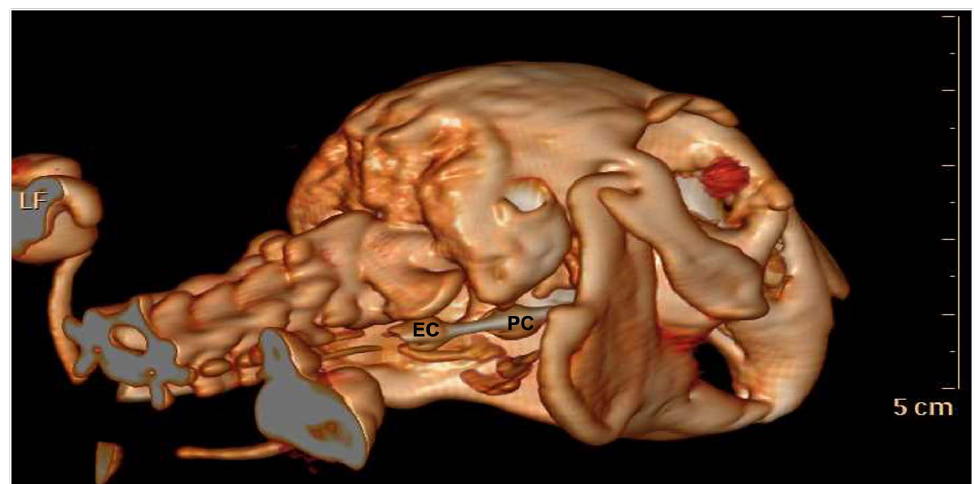
Figure 3. Tomographic image of a rabbit with the ST inserted. EC—esophageal cuff within the esophagus; PC—proximal cuff in the laryngeal vestibule (figure obtained from the archive of the Diagnostic image service of the Department of Veterinary Medical Sciences, University of Bologna). All the cardiorespiratory variables monitored remained within normal limits.